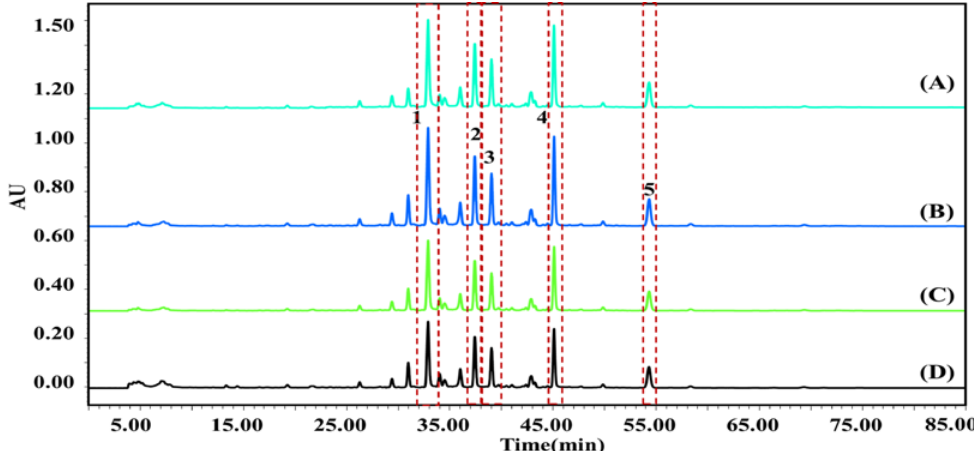
Figure 2. HPLC profiles of pure P. cocos extract ( D ) and extract combined with 0.5 ( A ), 1.0 ( B ), and 2.0 ( C ) U/mL acetylcholinesterase (AChE). (1) Tumulosic acid; (2) Polyporenic acid C; (3) 3-Epidehydrotumulosic acid; (4) Pachymic acid; (5) Dehydrotrametenolic acid.